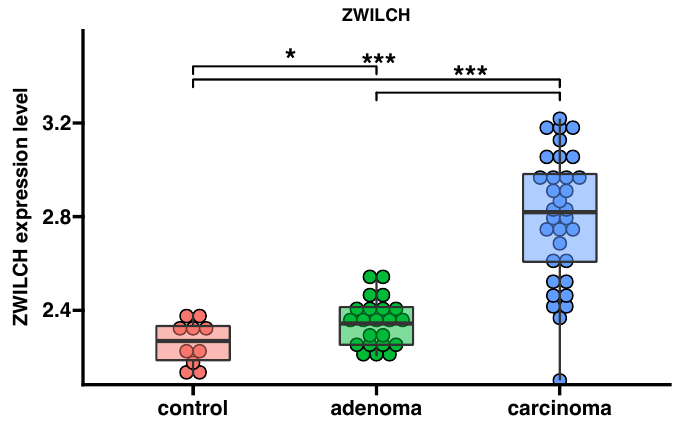
Figure 3. Expression profile of ZWILCH gene in the normal adrenal cortex (control, n = 10), adrenal adenoma ( n = 22), and adrenocortical carcinoma ( n = 33). Data were extracted from transcriptomic data deposited in the gene expression omnibus database (accession number: GSE10927). The bar plot presents the median with IQR range. Each dot represents ZWILCH expression in individual patients. Statistical differences were determined using the moderated t test * p < 0.05; *** p <